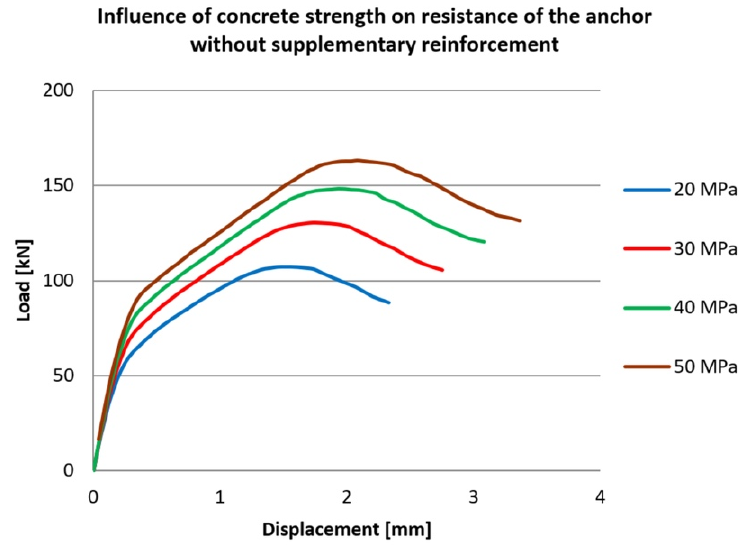
Figure 19. Influence of concrete compressive strength on the resistance of the anchor without supplementary reinforcement.